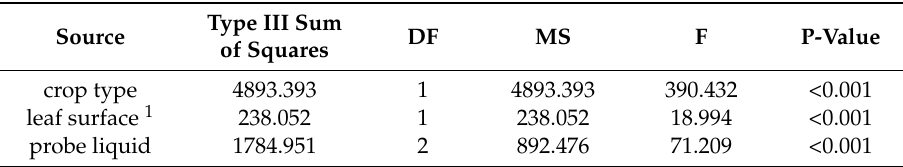
Table 4. Effect of crop type, leaf surface, and probe liquid on contact angles.